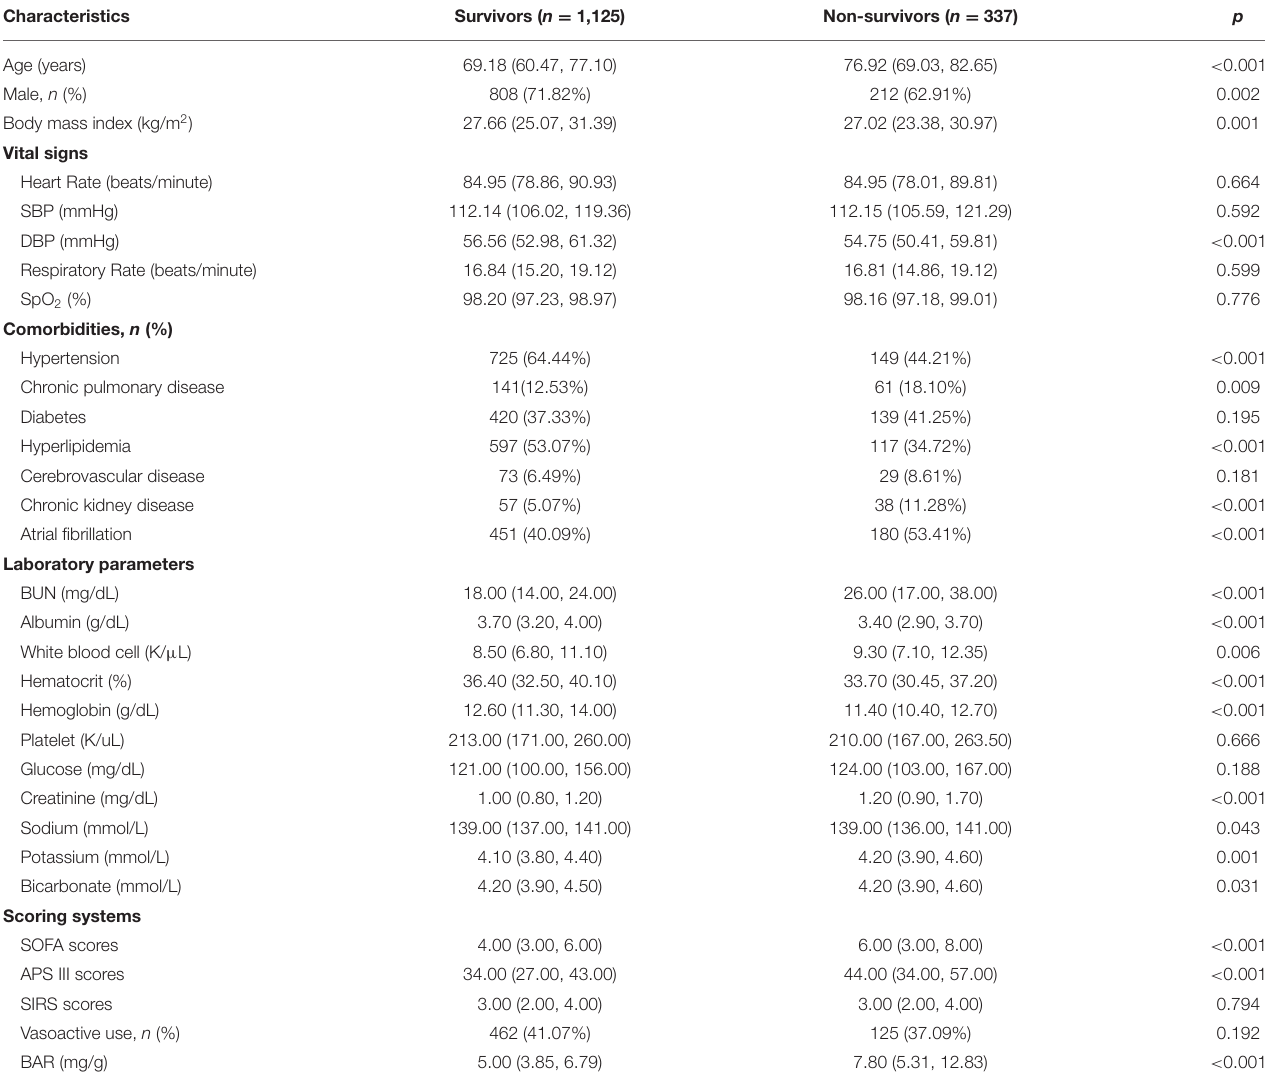
TABLE 1 | Patient characteristics of survivors and non-survivors at 4-year follow-up.